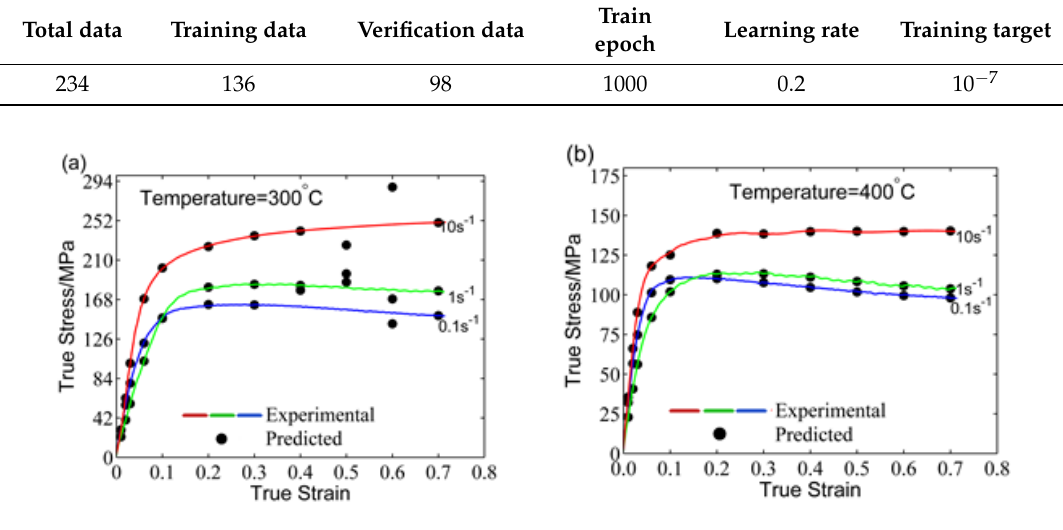
Table 2. The parameters of the ANN model.